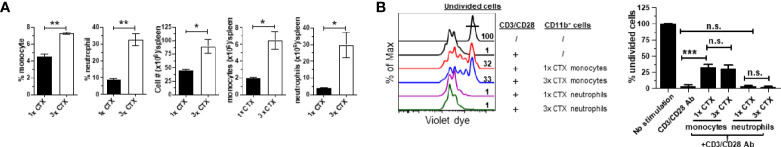
Repeated CTX administration results in enhanced expansion of myeloid cells. Mice were injected with CTX weekly for 3 weeks (3x-CTX). 7 days after the last CTX injection, spleen cells were harvested for analysis. Mice receiving one dose CTX (1x-CTX) were used for comparison. (A) Frequencies and numbers of monocytes and neutrophils in spleens are summarized in bar graphs with three mice each group. (B)
In vitro suppression assay. Violet dye-labeled responder T cells were mixed with equal numbers of sorted myeloid cells derived from mice receiving either one or three doses of CT and stimulated with aCD3/aCD28 mAbs. Proliferation of T cells was measured by violet dye dilution. The rightmost peak represents undivided T cells. Numbers in histogram indicate the percent of undivided responder T cells. The frequencies of undivided responder T cells under each culture condition are summarized in bar graph and shown as mean ± SD of triplicate cultures. Data shown are representative of two independent experiments. n.s., not significant, *p < 0.05, **p < 0.01, ***p < 0.001.